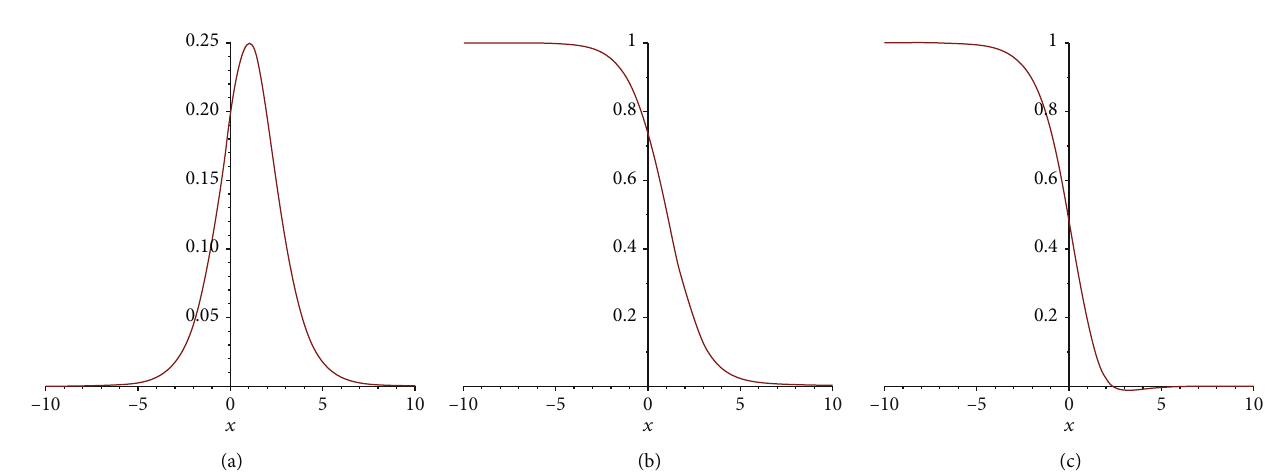
= τ = c = 1, and t = 1 1 2